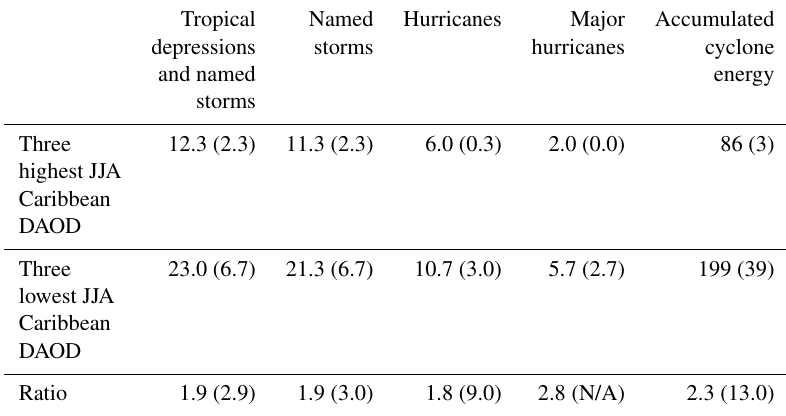
Table 2. Annual average Atlantic TC activity in the three seasons with the highest JJA Caribbean DAOD (2014, 2015, and 2018) and the three seasons with the lowest JJA Caribbean DAOD (2005, 2011 and 2017). Ratios between the three low-DAOD seasons and the three high-DAOD seasons are also provided. Corresponding numbers for the Caribbean are provided in parentheses next to the total basin-wide numbers. Tropical Named Hurricanes Major Accumulated depressions storms hurricanes cyclone and named